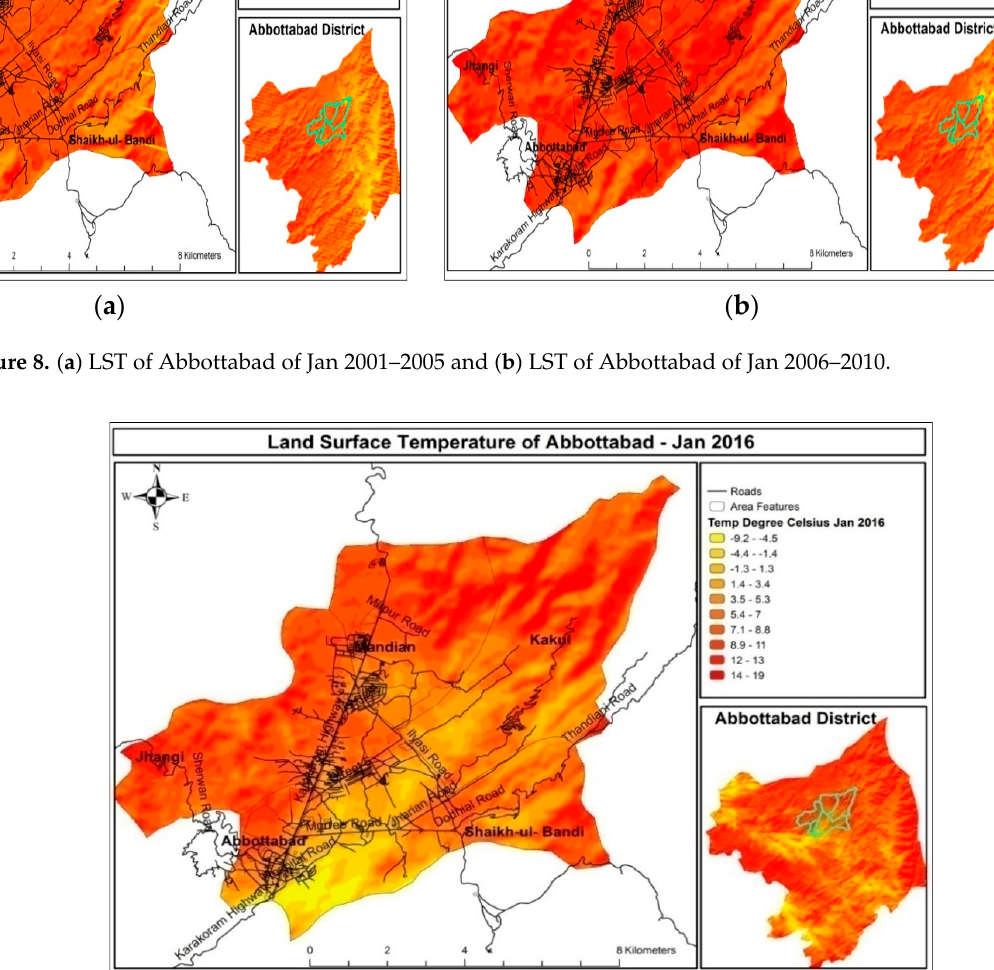
Figure 8. ( a ) LST of Abbottabad of Jan 2001–2005 and ( b ) LST of Abbottabad of Jan 2006–2010.